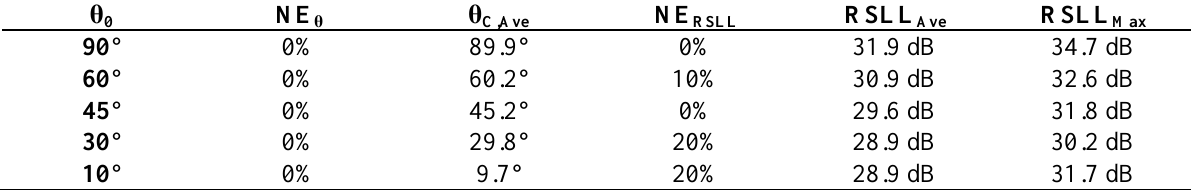
Table 1. Test results of the first application of GA-MMC